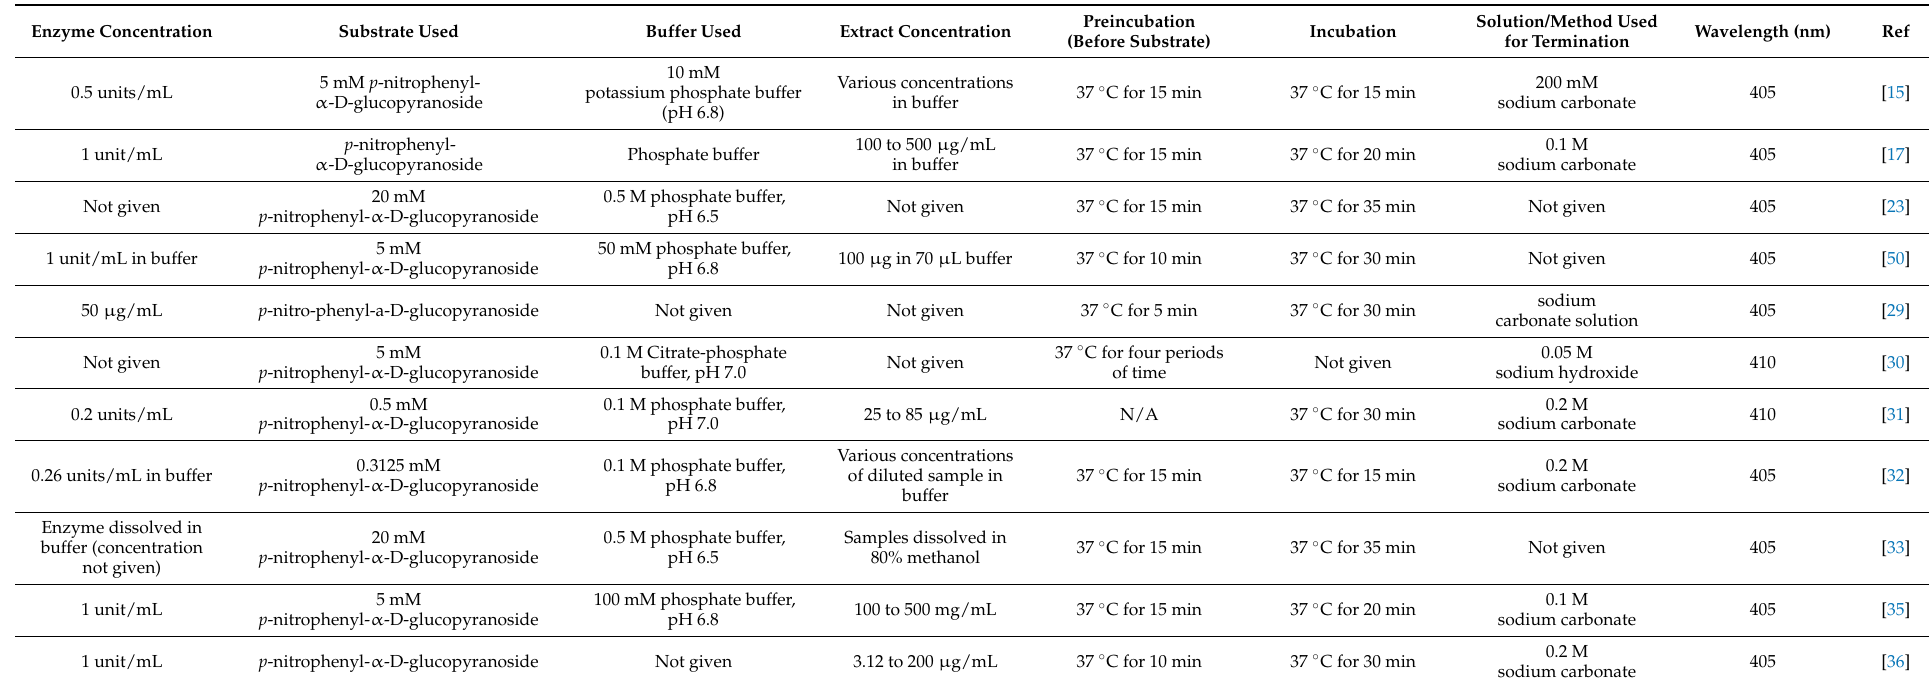
Table 4. Conditions used during the screening for α -glucosidase inhibitors using plant